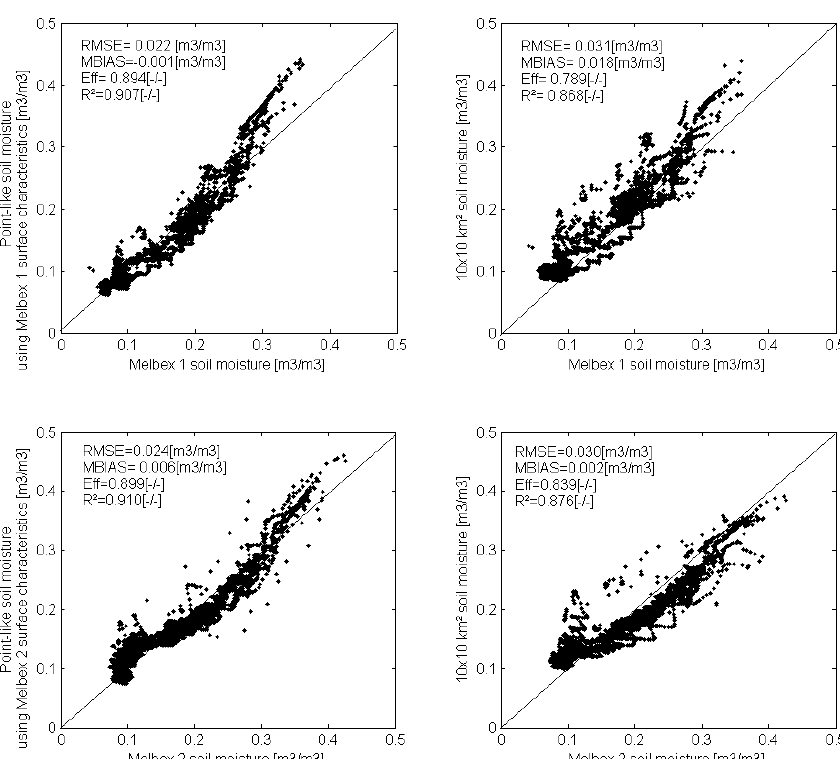
Fig. 6. Comparison between point like (left side) and 10 × 10km 2 simulations (right side) against ground measurements from Melbex 1 (up side) and Melbex 2 (down side) campaigns. The 10 × 10km 2 area is the one covering both Melbex 1 and Melbex 2 campaigns and data are extracted to correspond to both campaign